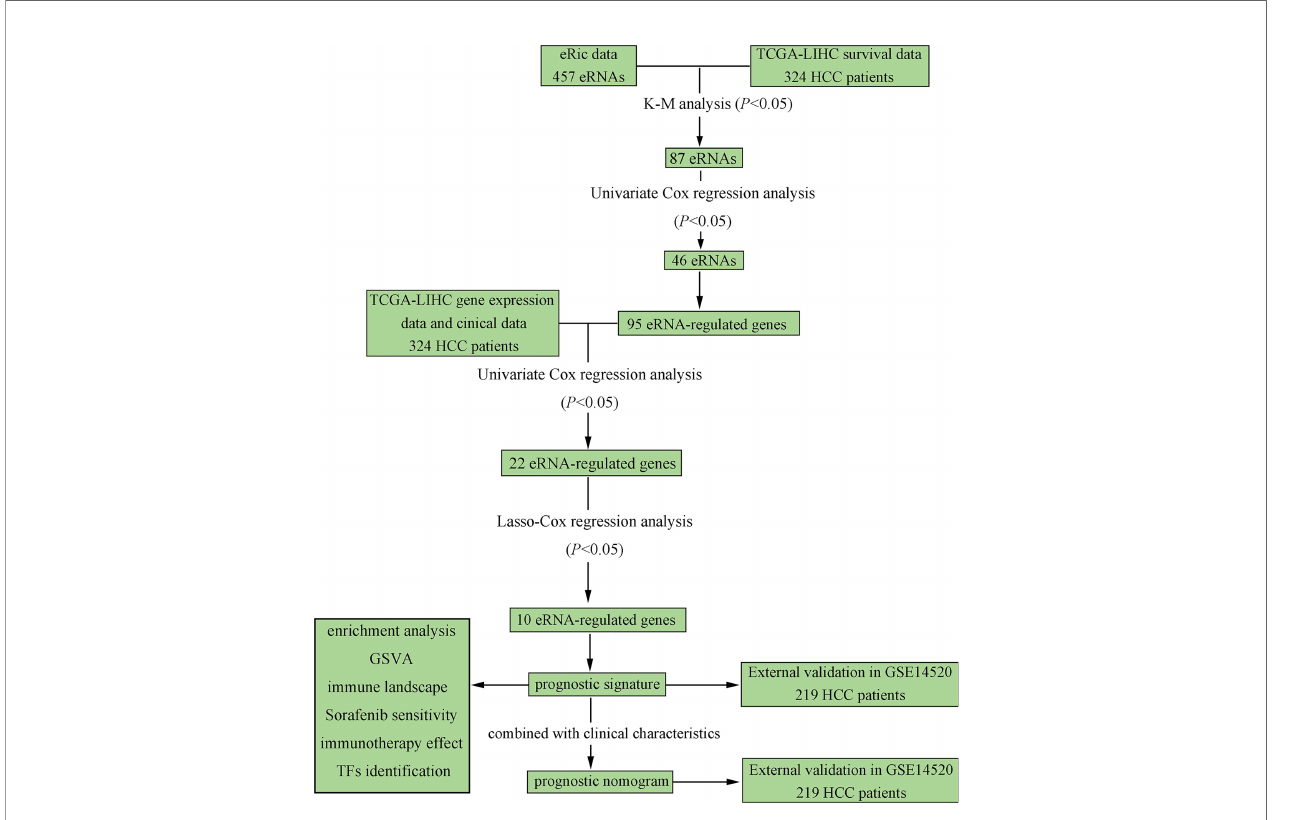
FIGURE 1 | Flowchart elaborating the scheme of construction and validation of prognostic signature and nomogram based on eRGs for HCC